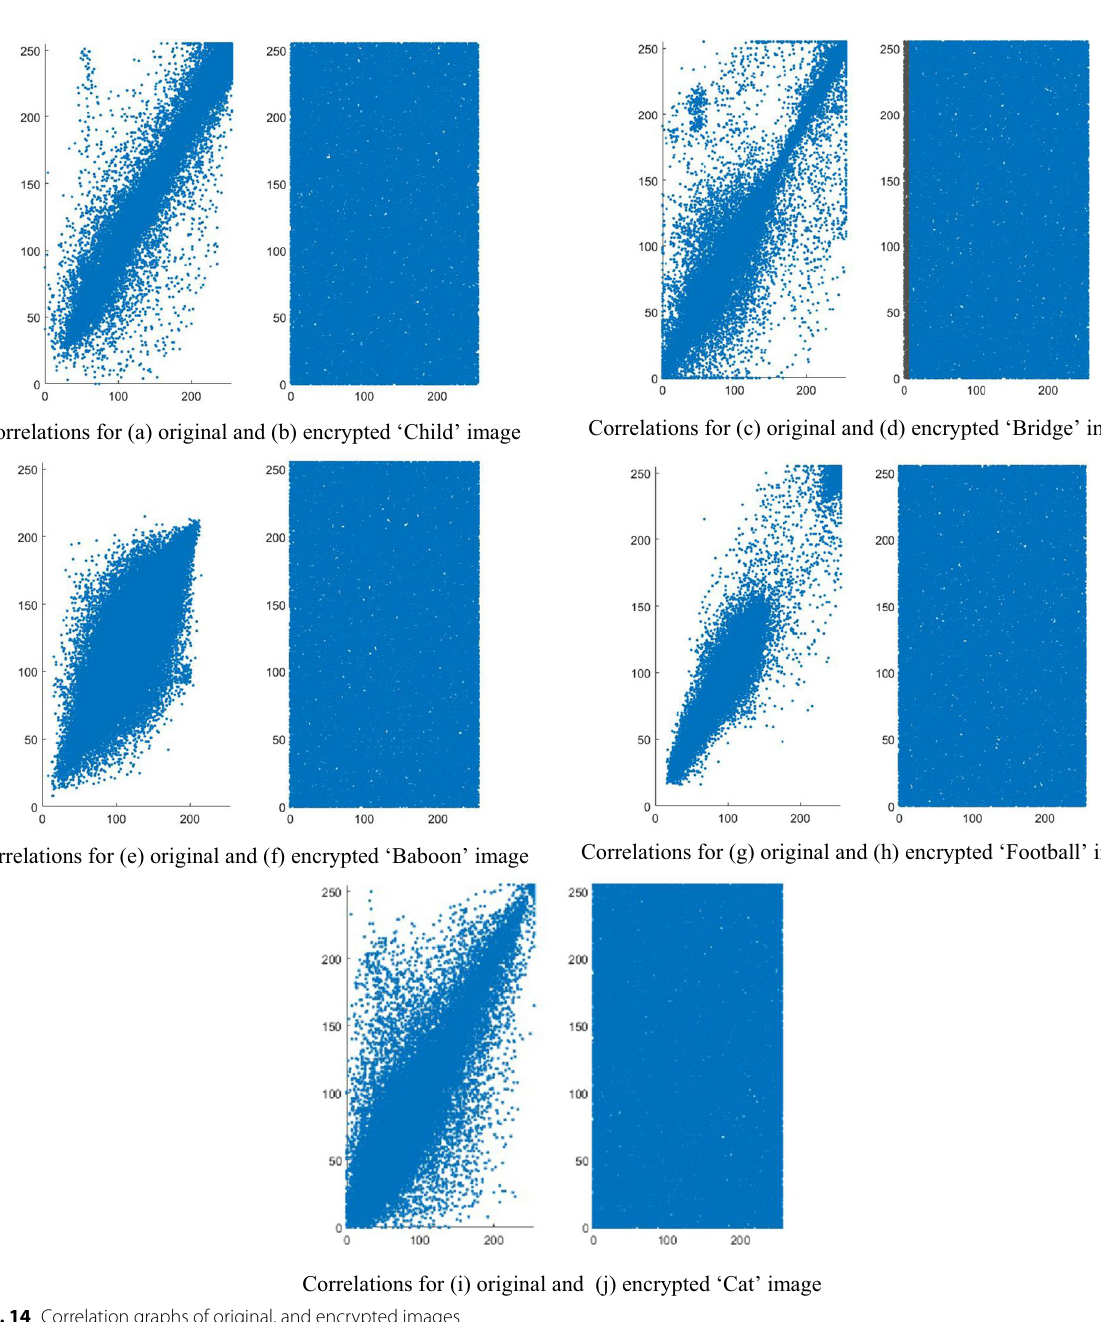
Fig. 14 Correlation graphs of original, and encrypted